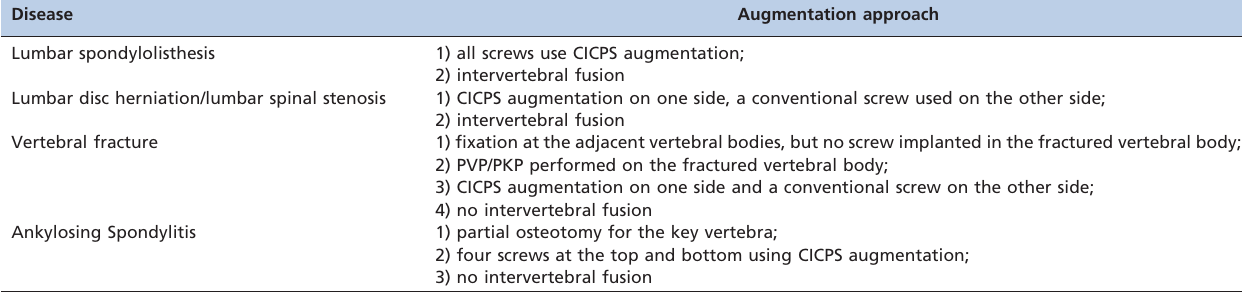
Table 2 - Suggestions for bone cement-injectable cannulated pedicle screw applications in different diseases. Disease Augmentation approach Lumbar